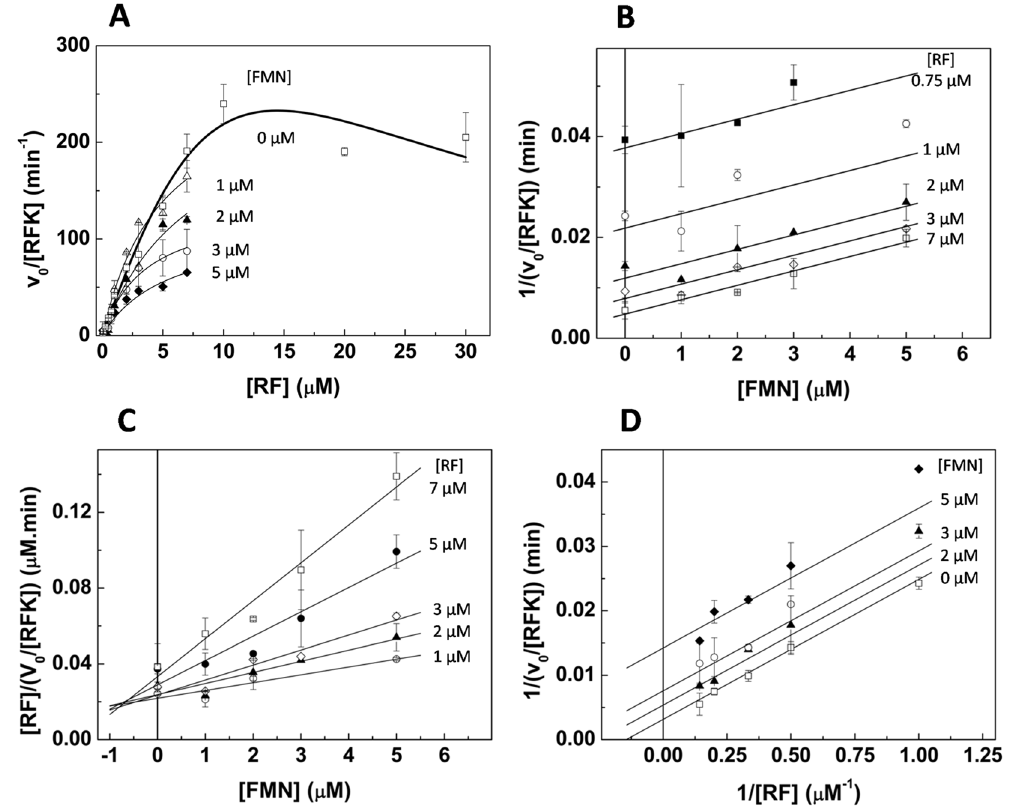
Figure 2. Inhibitory effects produced by the RF substrate and the FMN product in the steady-state RFK activity of the RFK module of Ca FADS. ( A ) Michaelis-Menten plots as a function of the RF substrate concentration at different concentrations of the FMN product (high fluorescence yields in mixtures that simultaneously contained RF and FMN prevented accurate determination of data over 7 µ M RF) and the corresponding ( B ) Dixon plot, ( C ) Cornish-Bowden plot and ( D ) Lineweaver-Burk representation. In ( A , C and D ) lines correspond to global fits to the equation for uncompetitive inhibition. Reaction rates were obtained in 20 mM PIPES and 0.8 mM MgCl 2 , pH 7.0, at 25 °C and a saturating level of ATP (350 μ M ATP), while the concentrations of the RF substrate (0–30 μ M) and the FMN product (0–7 μ M) were varied.